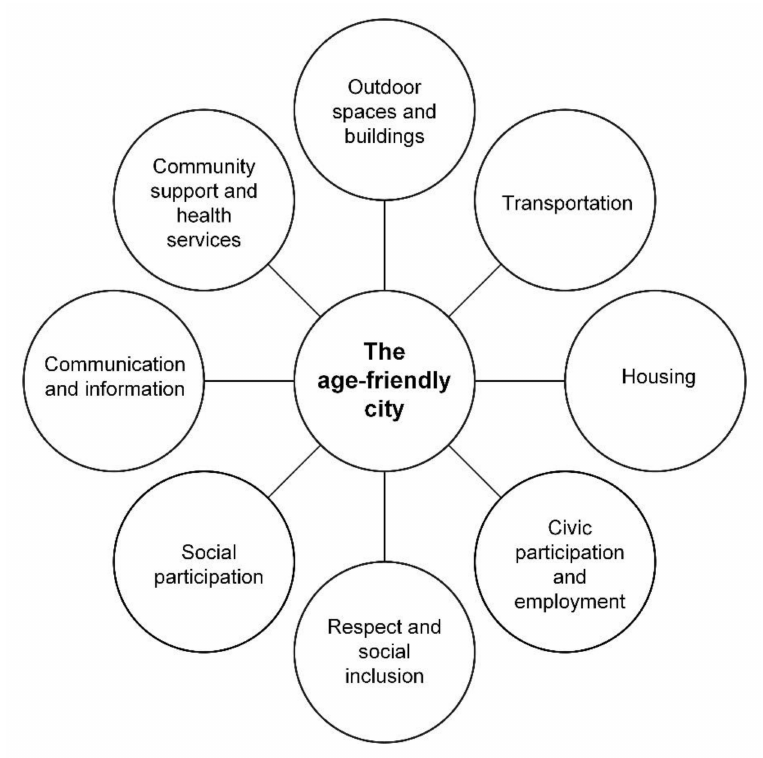
Figure 1. The eight domains of an age-friendly city [3].